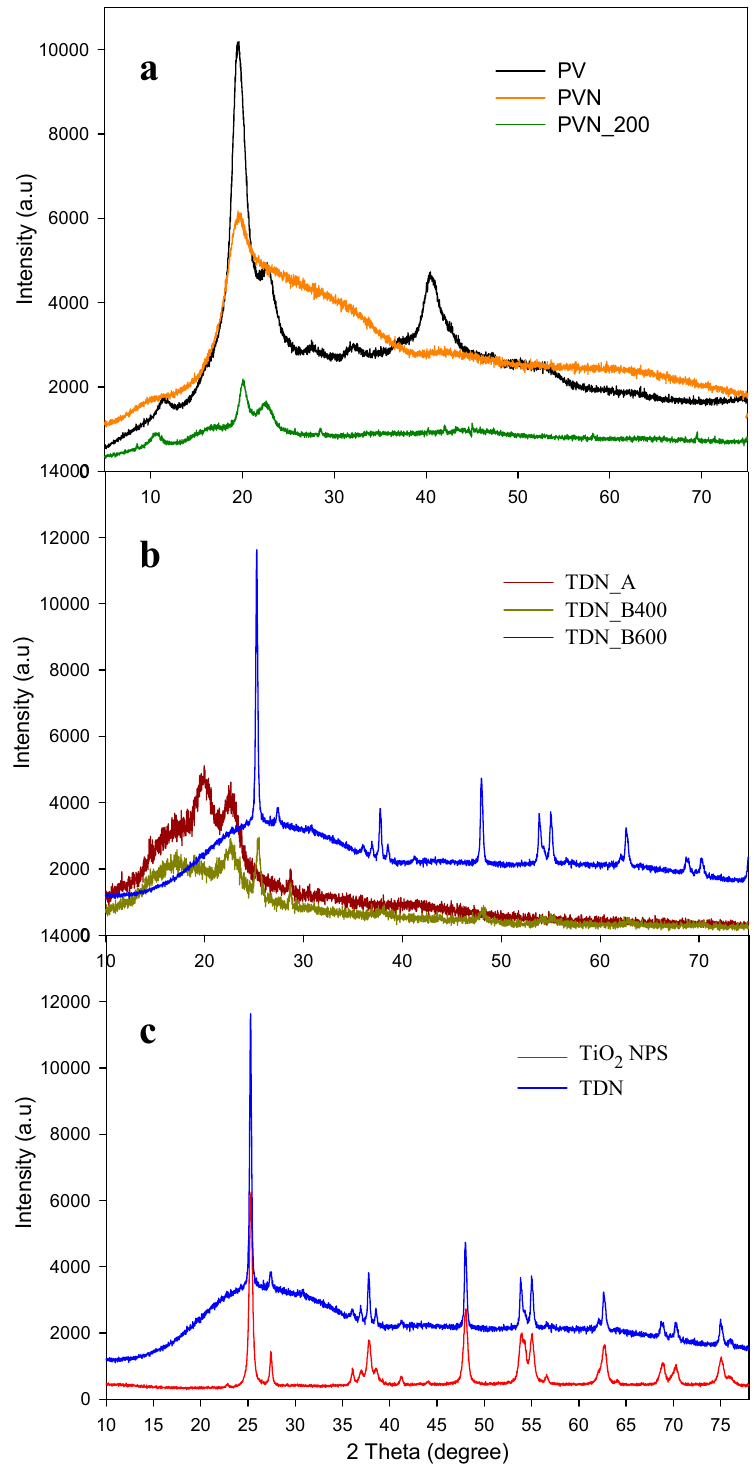
Figure 6. X-ray diffraction patterns of: ( a ) PV polymer and uncoated and coated through ALD PV electrospun nanofibers; ( b ) samples after removal polymer processes; and ( c ) commercial TiO 2 NPs and titanium dioxide nanotubes (TDN).